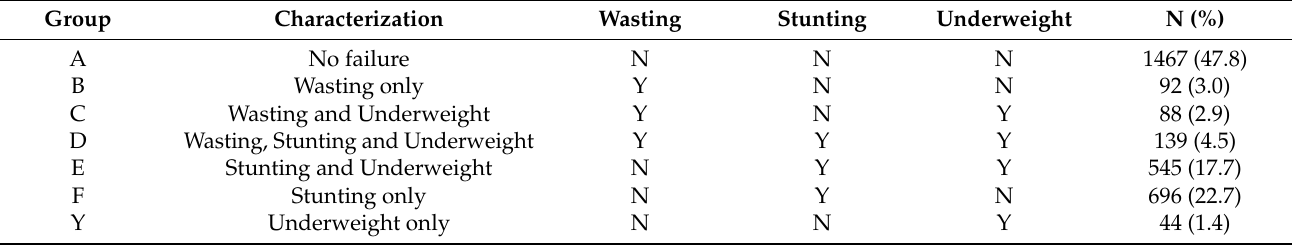
Table 1. For the creation of the response variable, different groups were used